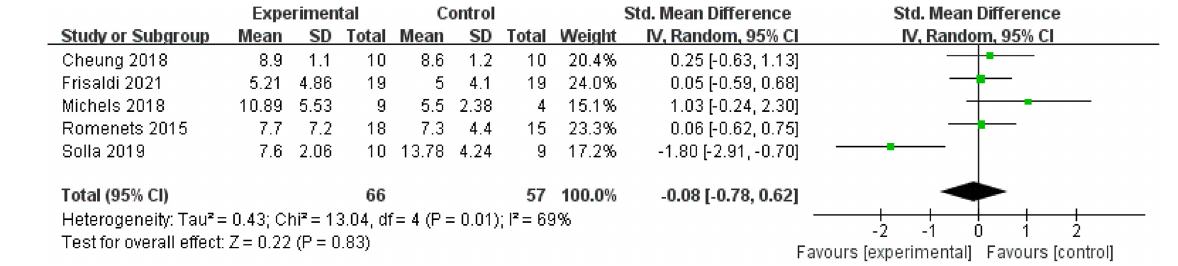
FIGURE 7 | Forest plot showing the effects of mind–body exercises on depression.